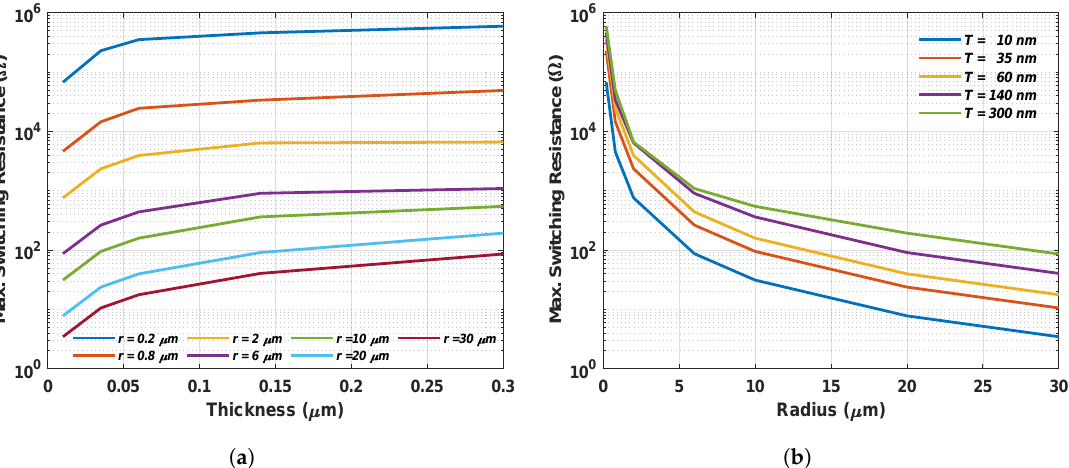
Figure 15. The dependence of the maximum switching resistance on ( a ) the thickness and ( b ) the radius of the VO 2